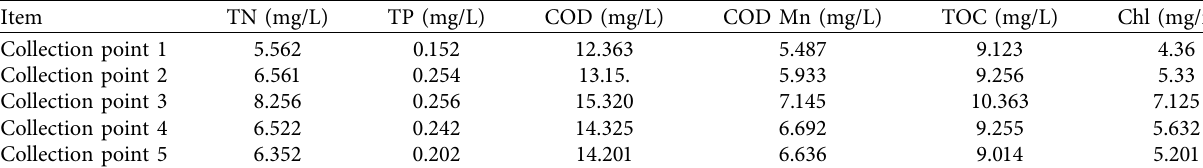
Table 1: Water quality related data in June 1st (excerpt).